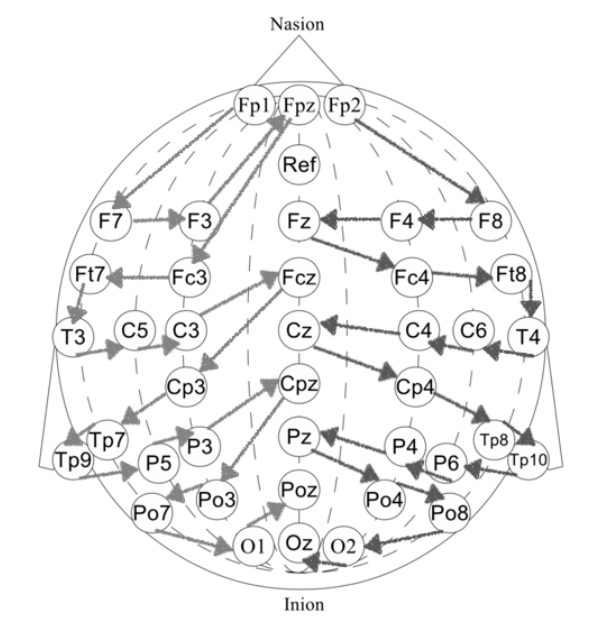
Figure 7. Separation of electrodes into the left and right hemispheres with number of channels and spatial balance between